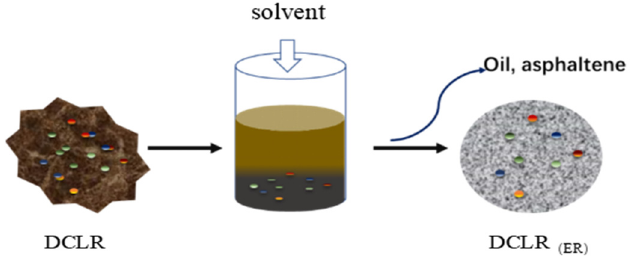
Figure 14. DCLR (ER) and organic matter separated by 1-butyl-3-methylimidazole nitrate. Table 6. The analysis of the DCLR (ER) component.